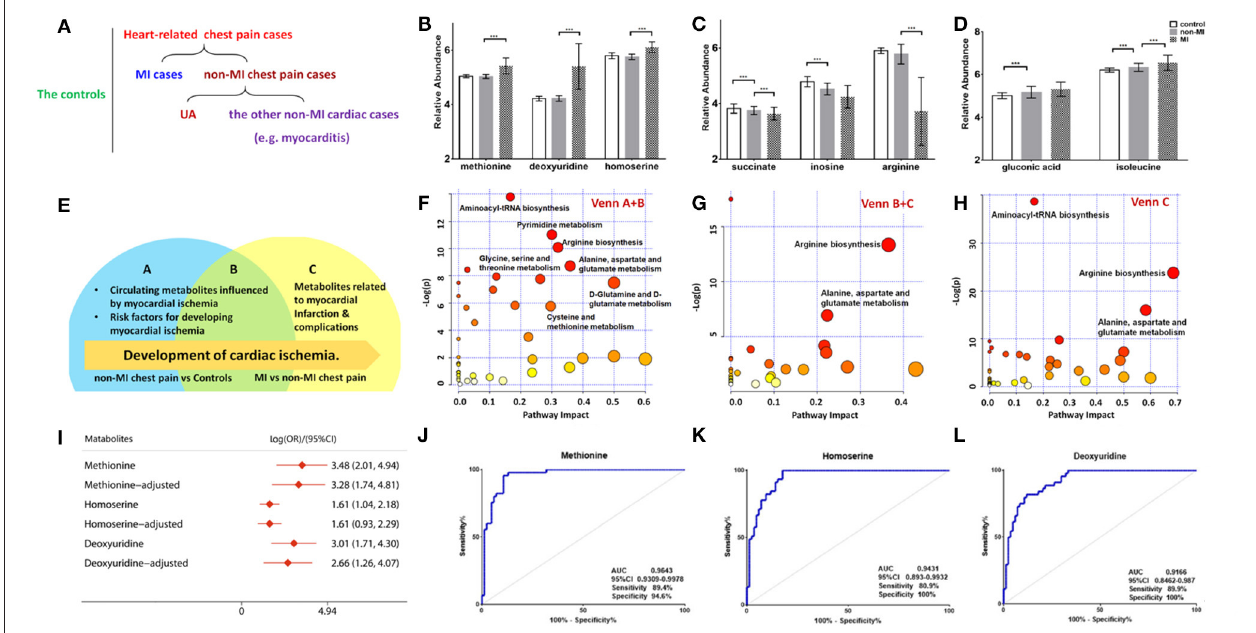
FIGURE 3 | Differential metabolites and pathways involved in the MI group. (A) Samples are divided into three groups: control ( n = 84), MI ( n = 85) cases, and non-MI chest pain cases ( n = 61); or four groups: control ( n = 84), MI cases ( n = 85), UA ( n = 34), and the other non-MI cardiac cases ( n = 27) when OPLS-DA analysis is applied. (B) Plasma methionine, deoxyuridine, and homoserine levels spike in the MI group. (C) Succinate, inosine, and arginine levels drop as CAD progresses to MI. (D) Gluconic acid and isoleucine levels increase as CAD progresses to MI (relative abundance is shown in logarized form: mean with SD, *** p < 0.05). (E) Venn diagram shows discriminant metabolites can be classified into regions A, B, and C. (F) Pathway analysis of differential metabolites in Venn A and B regions (control vs. non-MI chest pain cases). (G) Pathway analysis of differential metabolites in Venn C and B (MI vs. non-MI cases). There is a remarkable change of arginine biosynthesis and alanine, aspartate, and glutamate metabolism. (H) Pathway analysis of differential metabolites in Venn C. There is a remarkable change of arginine biosynthesis and alanine, aspartate, and glutamate metabolism. (I) Unadjusted and adjusted (adjusted for age, gender, LDL-C, HDL-C, smoking/diabetic/hypertensive history) odds ratio of methionine, deoxyuridine, and homoserine. (J) Receiver operating characteristic curve (ROC) analysis of methionine [area under the ROC curve (AUC) 96.43%, sensitivity 89.4%, specificity 94.59%]. (K) ROC analysis of homoserine (AUC 94.31%, sensitivity 80.9%, specificity 100%). (L) ROC analysis of deoxyuridine (AUC 91.66%, sensitivity 80.9%, specificity 100%) (*** p <